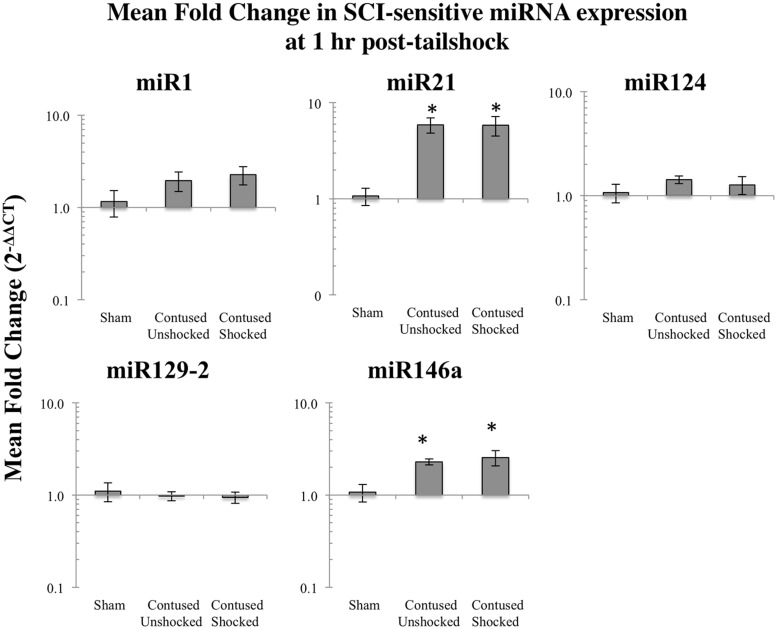
Bar graphs depicting qRT-PCR analysis of miRNA expression of miR1, miR21, miR124, miR129-2, and miR146a at the lesion site for sham animals and after unshocked or shock treatment in contused animals at 1 h following tailshock treatment. The x-axis denotes treatment condition, and the y-axis denotes the log of mean fold expression change of miRNA. Data are normalized relative to U6 small nuclear RNA internal gene expression and expressed as the mean of all fold changes of individual samples within a treatment group relative to the mean of the treatment group, with asterisks indicating significance (LSD) compared with sham controls; p values are as indicated in the text. The error bars indicate the standard error of the mean (SEM).